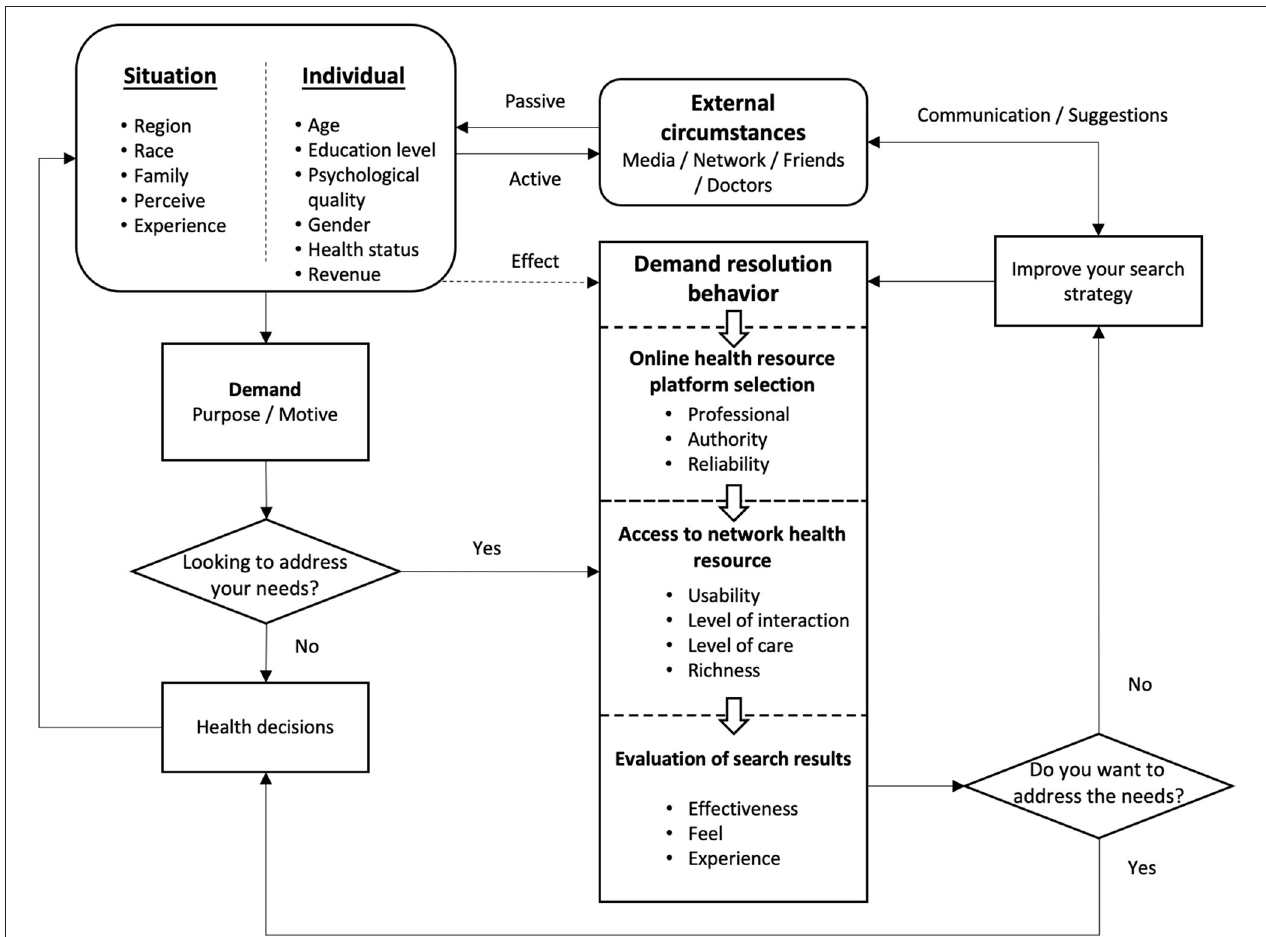
FIGURE 7 | Online health information seeking behavior